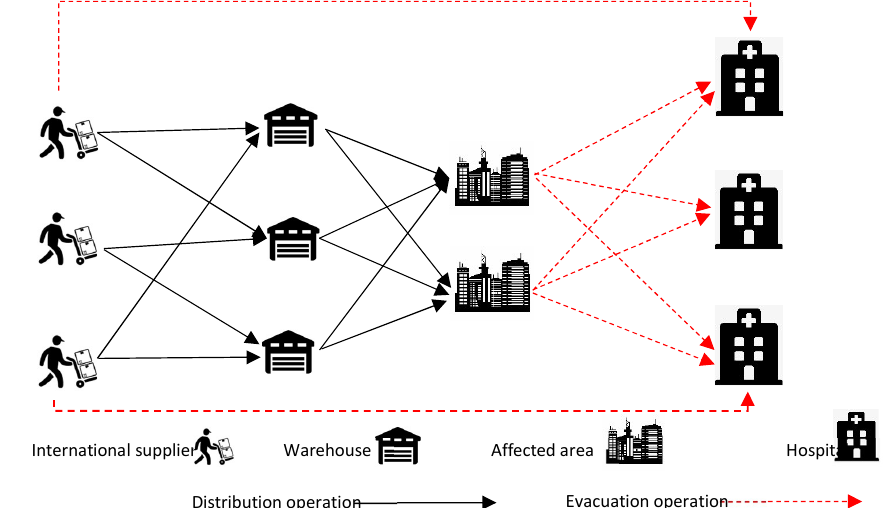
Fig. 1 . Schematic structure of the